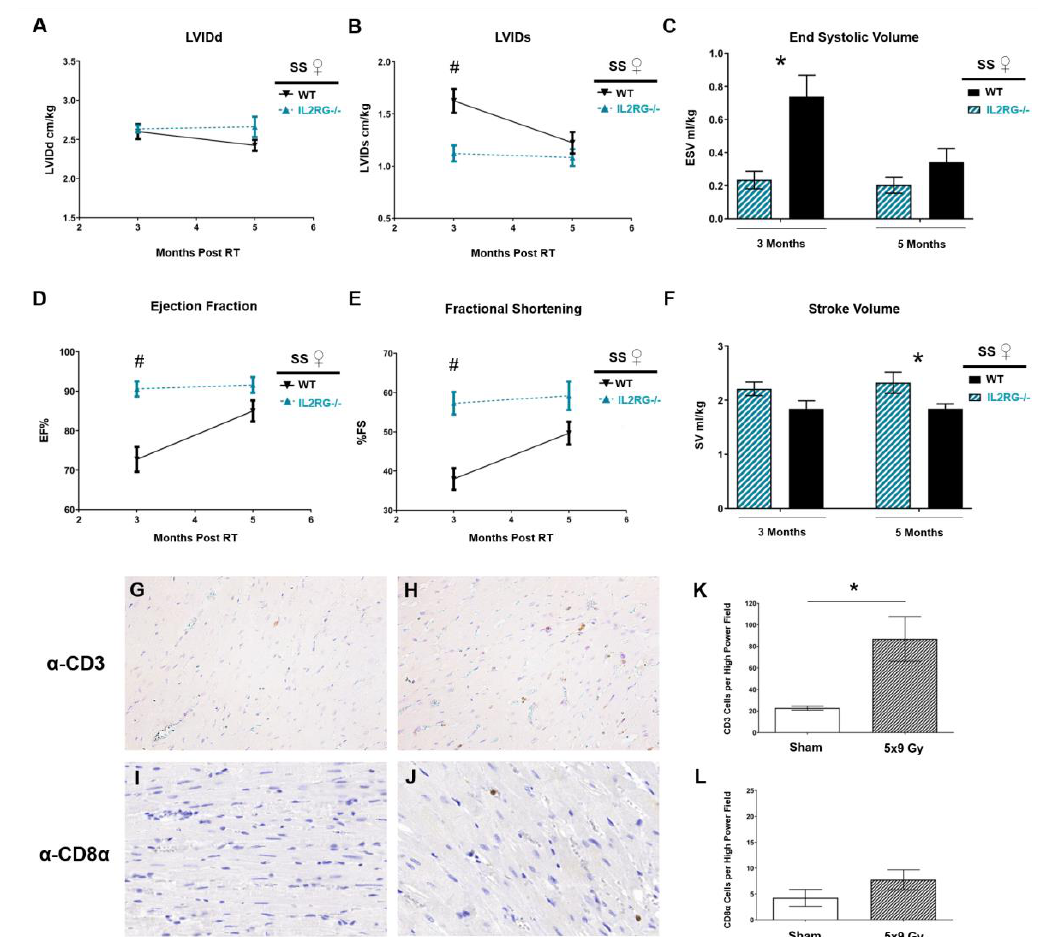
Figure 7. SS IL2RG − / − immune-compromised rats versus SS WT immune-competent rats receiving fractionated 9 Gy × 5 cardiac radiation have slightly less cardiac damage measured via echocardiogram. Female SS IL2RG − / − and SS WT rats received 9 Gy × 5 localized cardiac radiation, and